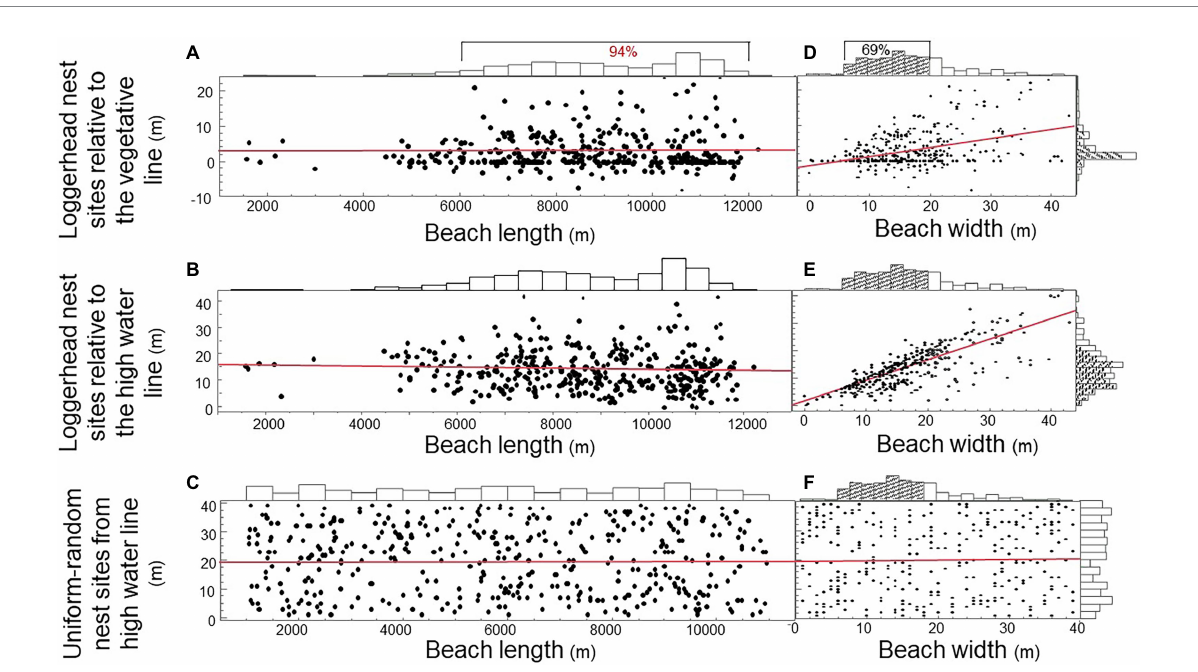
FIGURE 4 Distributions and predictors of loggerhead sea turtle nest sites on Keewaydin Island beach, Naples Florida, United States. (A) Emergence sites of loggerhead females along the beach-length axis by the distance of nest sites from the vegetative line. (B) Emergence sites along the beach-length axis by the distance of nest sites from the high water line. (C) Uniform-random emergence sites along the beach-length axis and nest site locations along the beach-width axis. (D) Nest site location by loggerhead females along the beach-width axis by the distance of nest sites from the vegetative line. (E) Nest sites along the beach-width axis by the distance of nest sites from the high water line. (F) Uniform-random nest sites along the beach-length axis by the beach-width